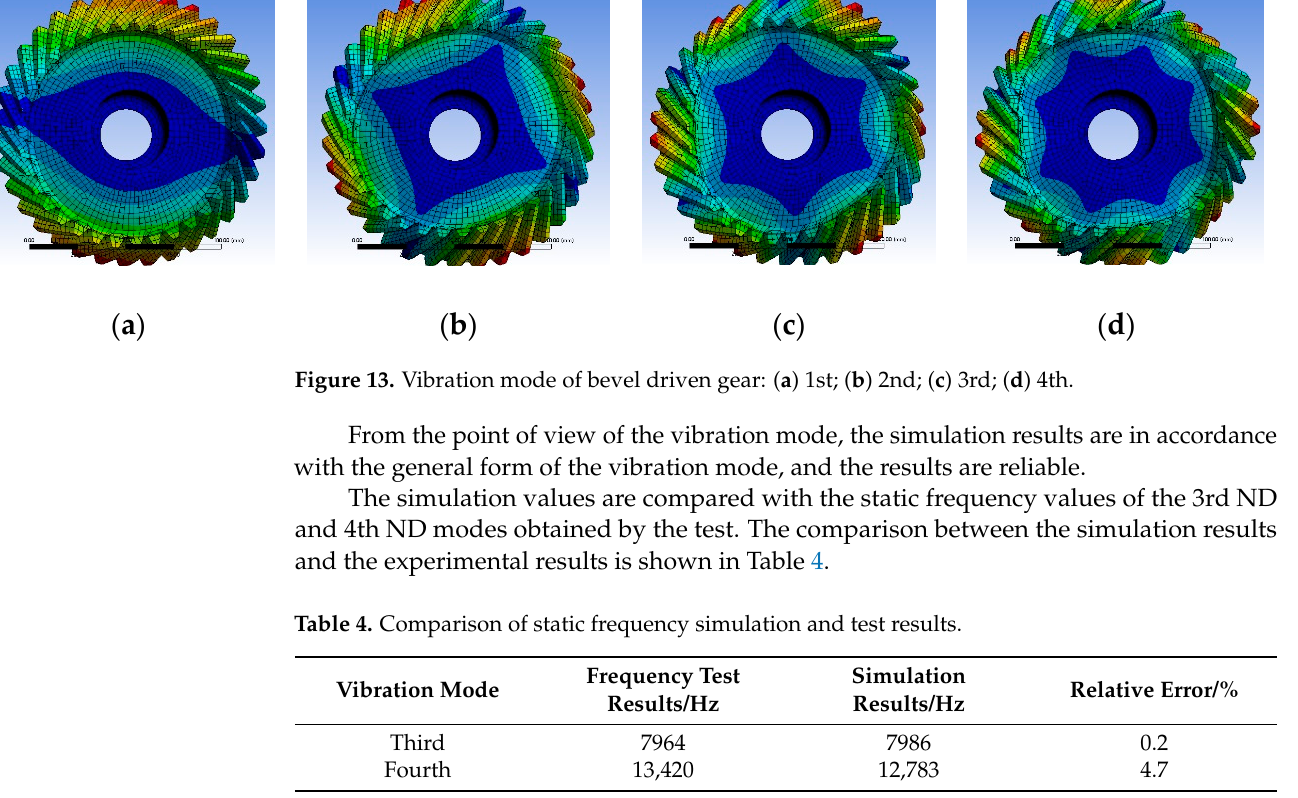
( b ) Figure 12. constraint setting of driven bevel gear. ( a ) constraint diagram; ( b ) constraints in FEM model. The ambient temperature was set to 20 ℃ , and the first 18 modes were extracted, from which the modes of the 1st NC, 2nd ND, 3rd ND and 4th ND were selected. The static frequency of the 1st NC to the 4th ND obtained by simulation are shown in Table 3, and the mode diagram of vibration is shown in Figure 13.